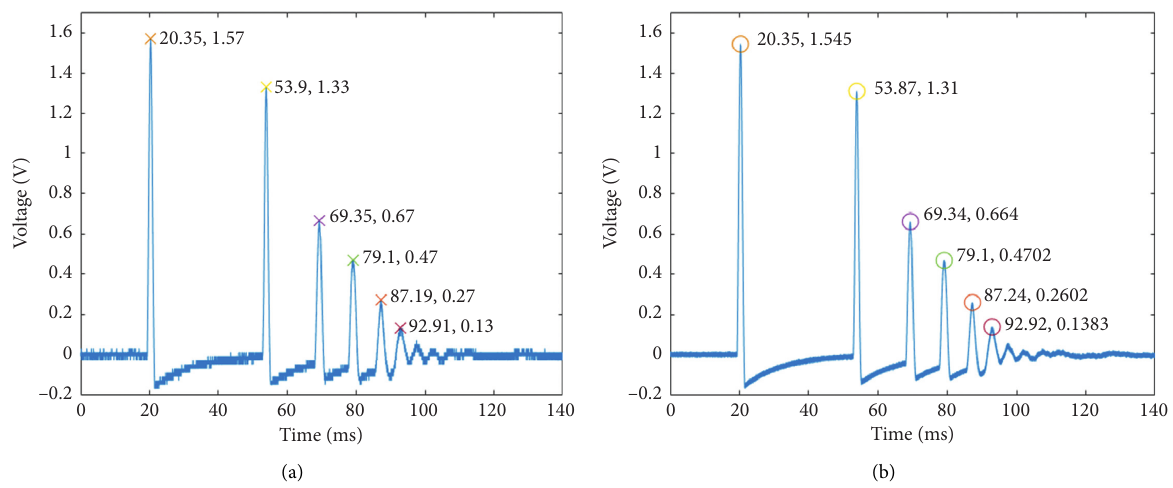
Figure 8: Voltage versus time curves. (a) Voltage signal acquired by the oscilloscope. (b) Voltage signal acquired by the DAR circuit.